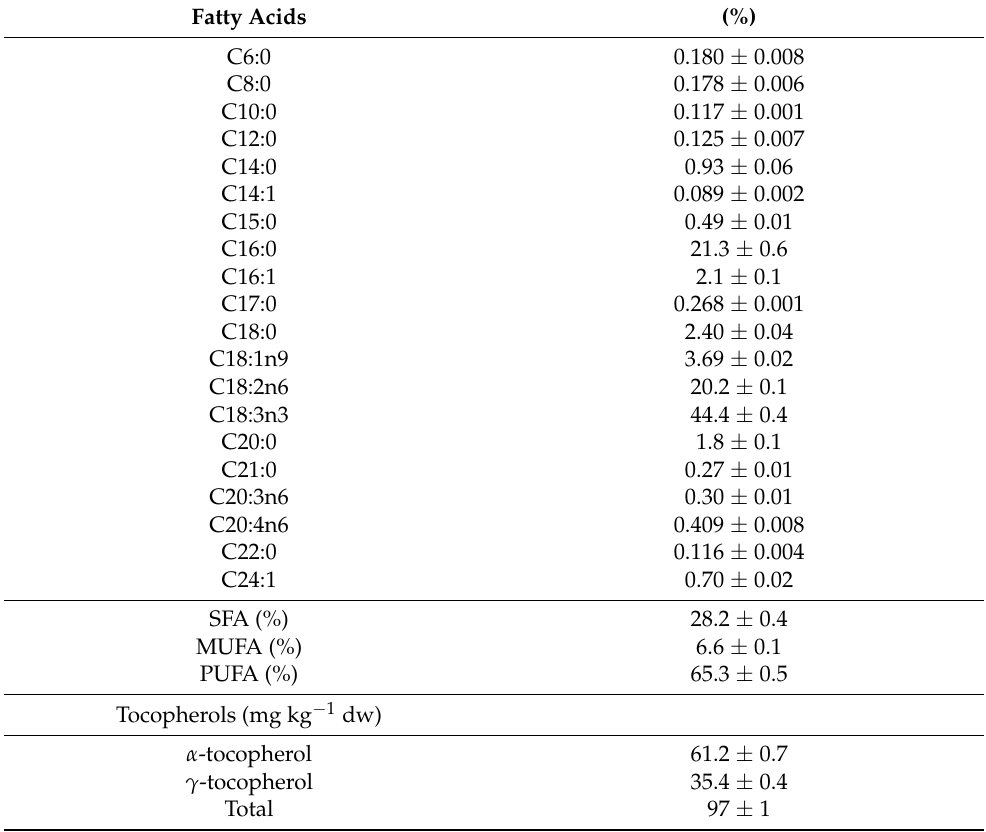
Table 2. Chemical composition with regard to lipophilic compounds of L. canadensis (mean ± SD, n = 3). Fatty